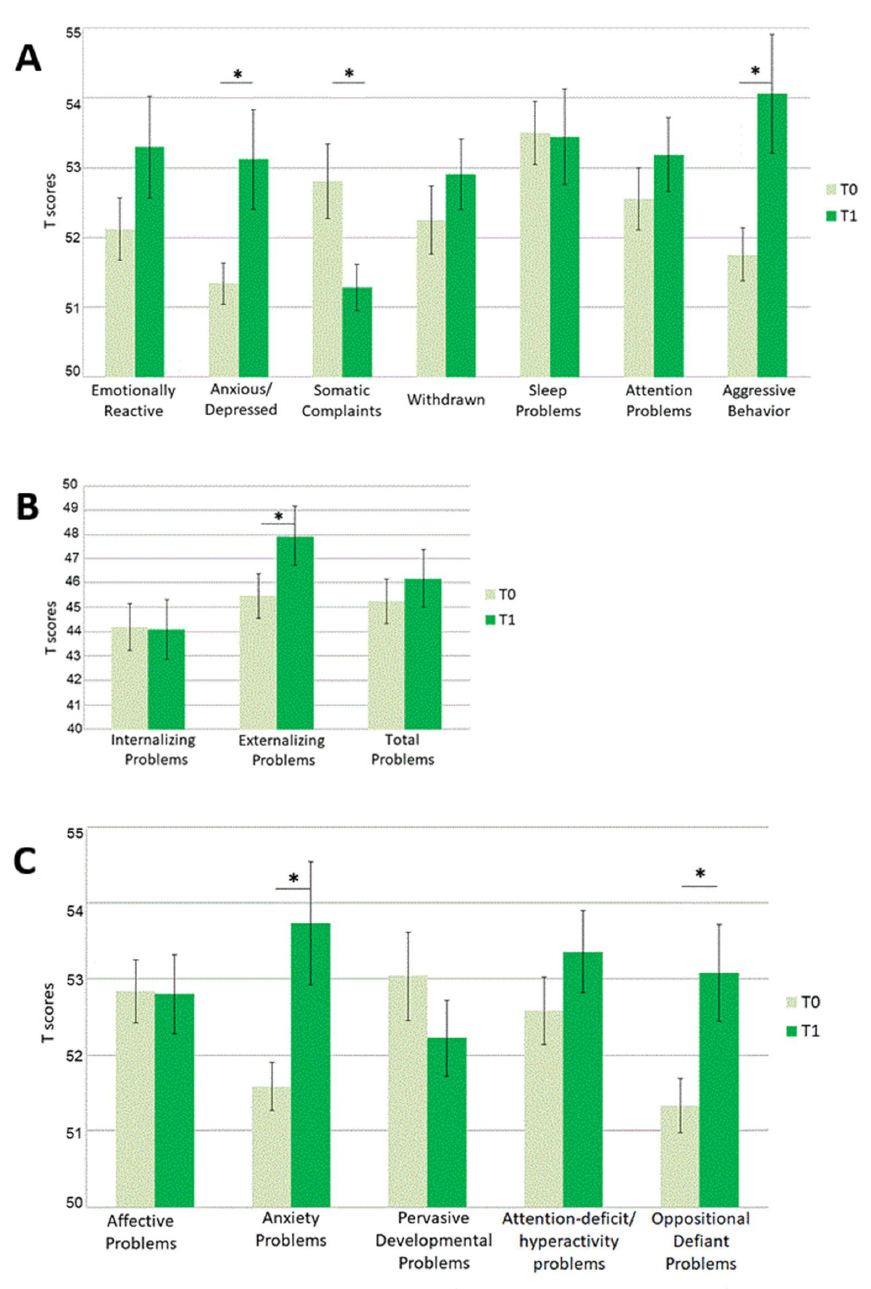
Figure 1. Descriptive graphical representation of mean T-scores (and Standard Errors) for each CBCL 1.5–5 scale. T-scores at T0 (grey bars) are plotted against T-scores at T1(green bars) for ( A ) Syndrome scales, ( B ) Composite scales, and ( C ) DSM-oriented scales. Asterisks (*) indicate significant differences between T-scores at T0 and at T1.